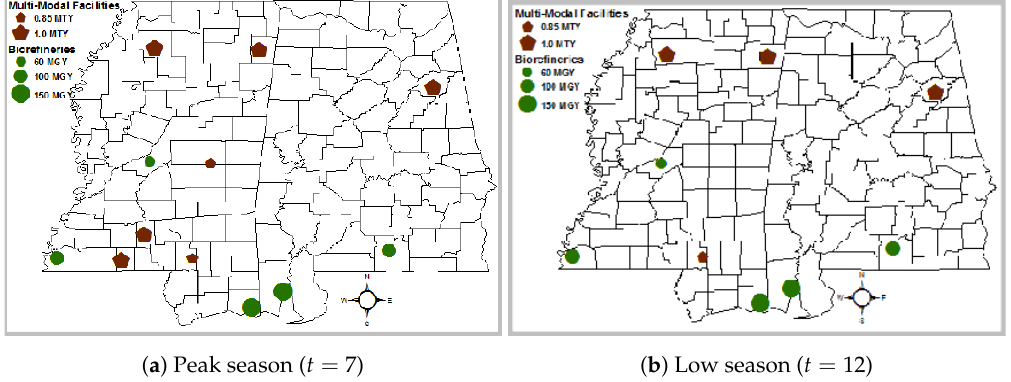
Figure 6. Network representation under risk neutral